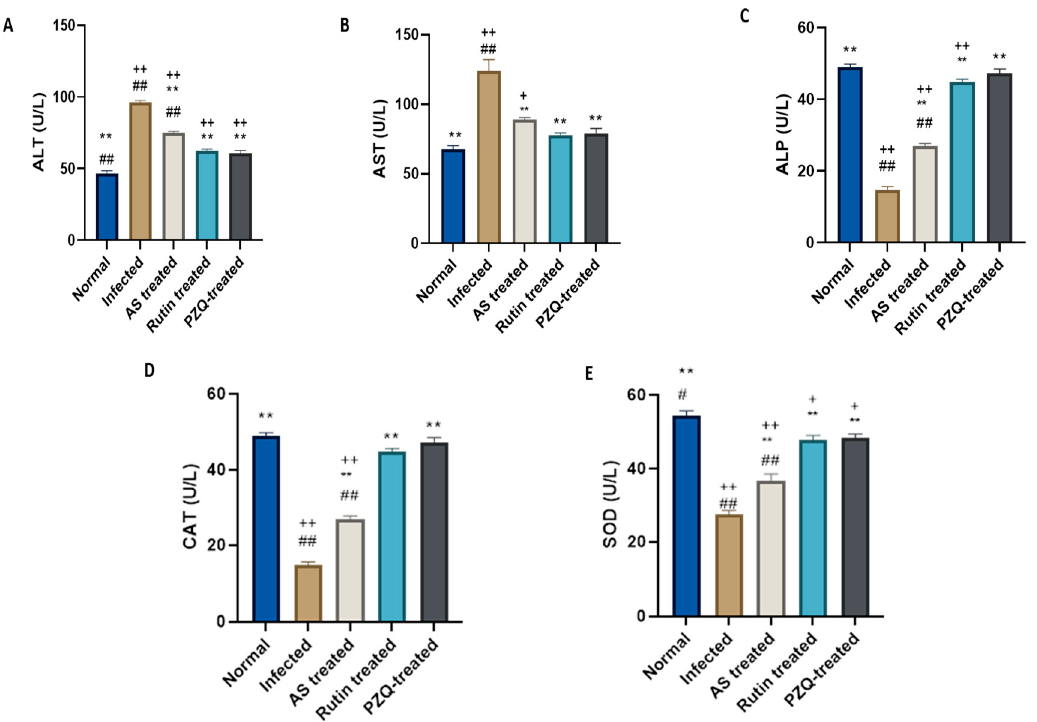
Figure 3. Effect of treatment with rutin naturally isolated from A. sativum on the liver biomarkers. Effect of different treatments on ( A ) ALT; ( B ) AST; ( C ) ALP; ( D ) CAT activity; ( E ) SOD activity. Data expressed as mean ± SE ( n = 10). p -value represented the relationship between AS b- and rutin-treated groups and normal control, S. mansoni -infected controls and drug controls. * p < 0.05, ** p -value < 0.001, compared with infected control group; + p < 0.05, ++ p -value < 0.001 in comparison to normal control group; # p < 0.05, ## p -value < 0.001 in comparison to PZQ control group.